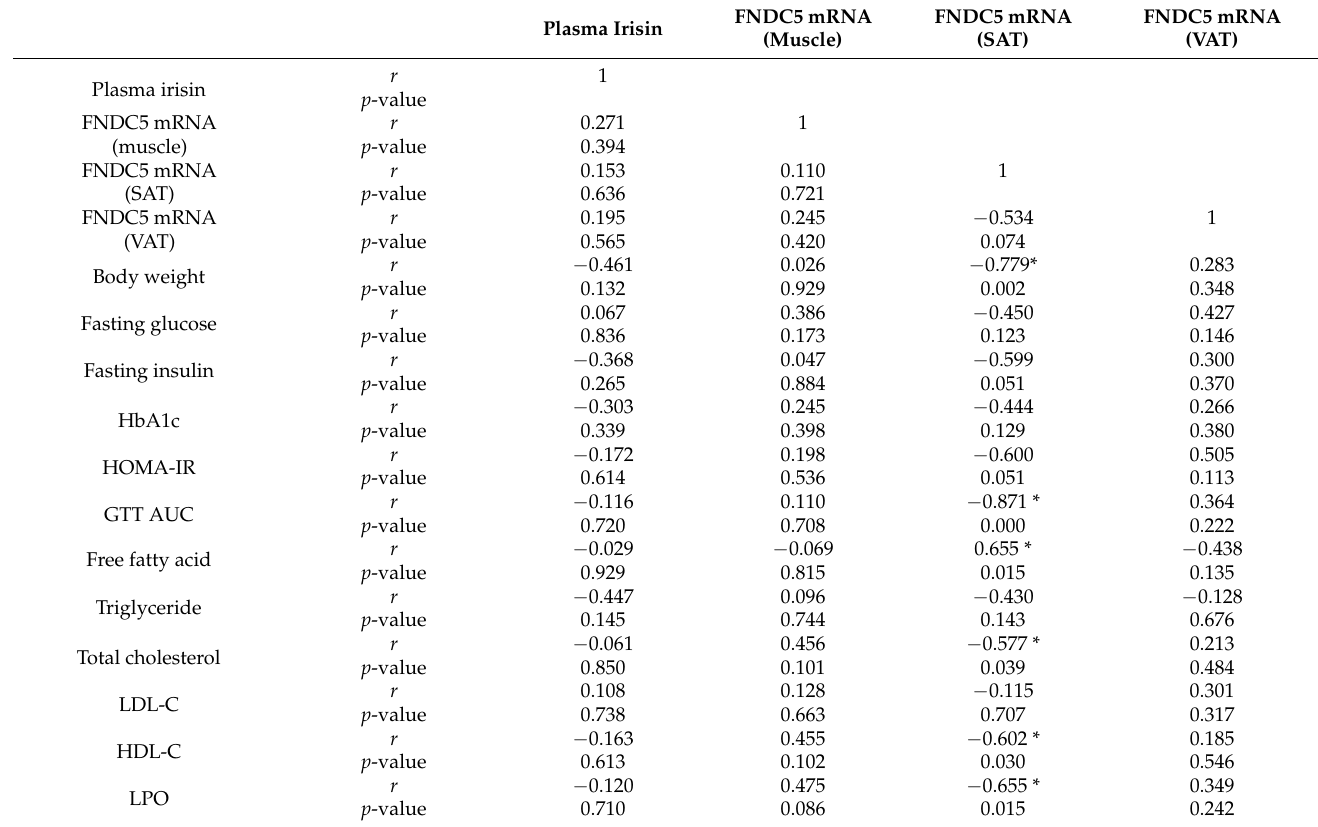
Table 3. Correlation between plasma irisin, FNDC5 mRNA, and metabolic parameters in HFD-fed mice.